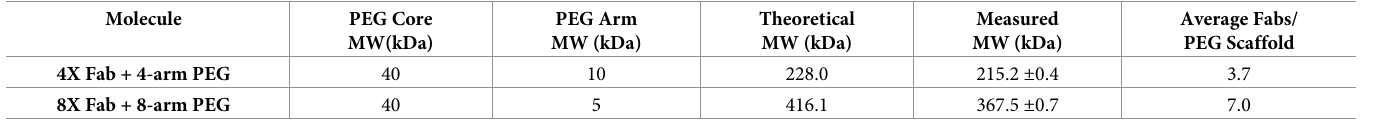
Table 2. Comparison of theoretical MW of each conjugate relative to that measured by SEC-MALS. Average Fabs per PEG scaffold was determined by subtracting the MW of the PEG core and dividing by the MW of the Fab.